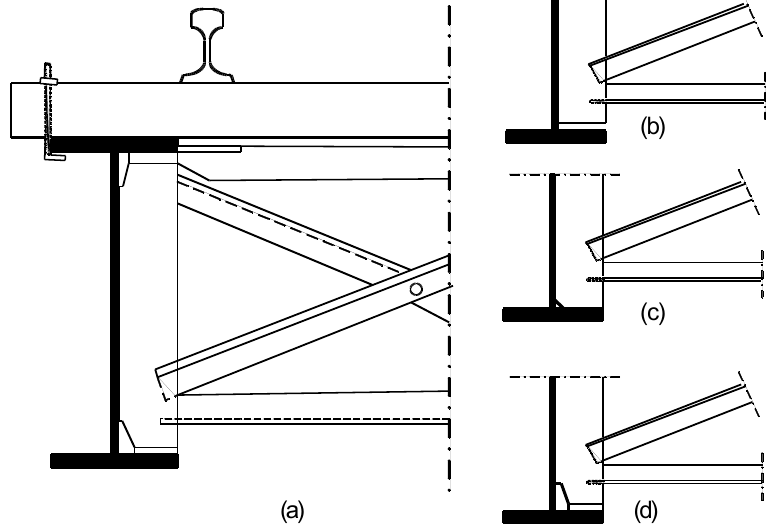
Figure 11. Detailing of the connection of cross-bracing elements to bridge